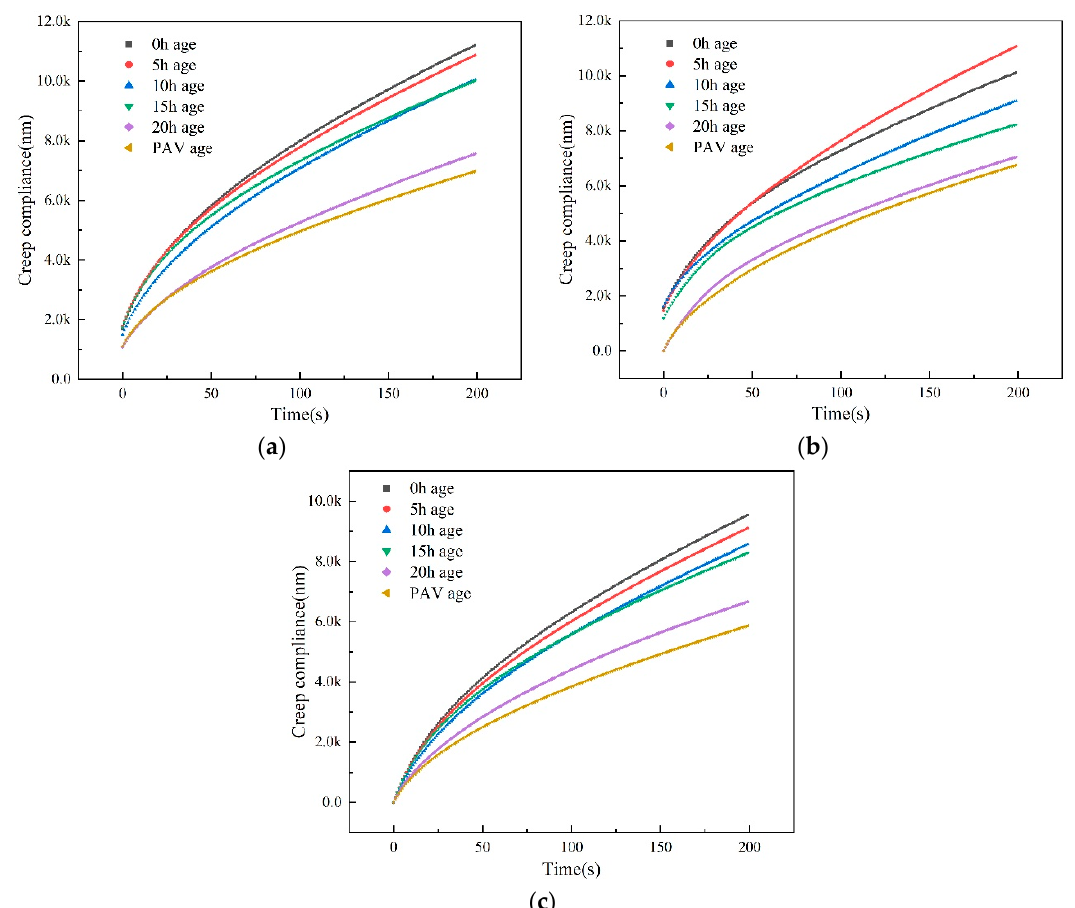
Figure 8. Nano-indentation mechanical response curves of different asphalt mixtures: ( a ) Basalt aggregates; ( b ) aluminous aggregates; ( c ) limestone aggregates.